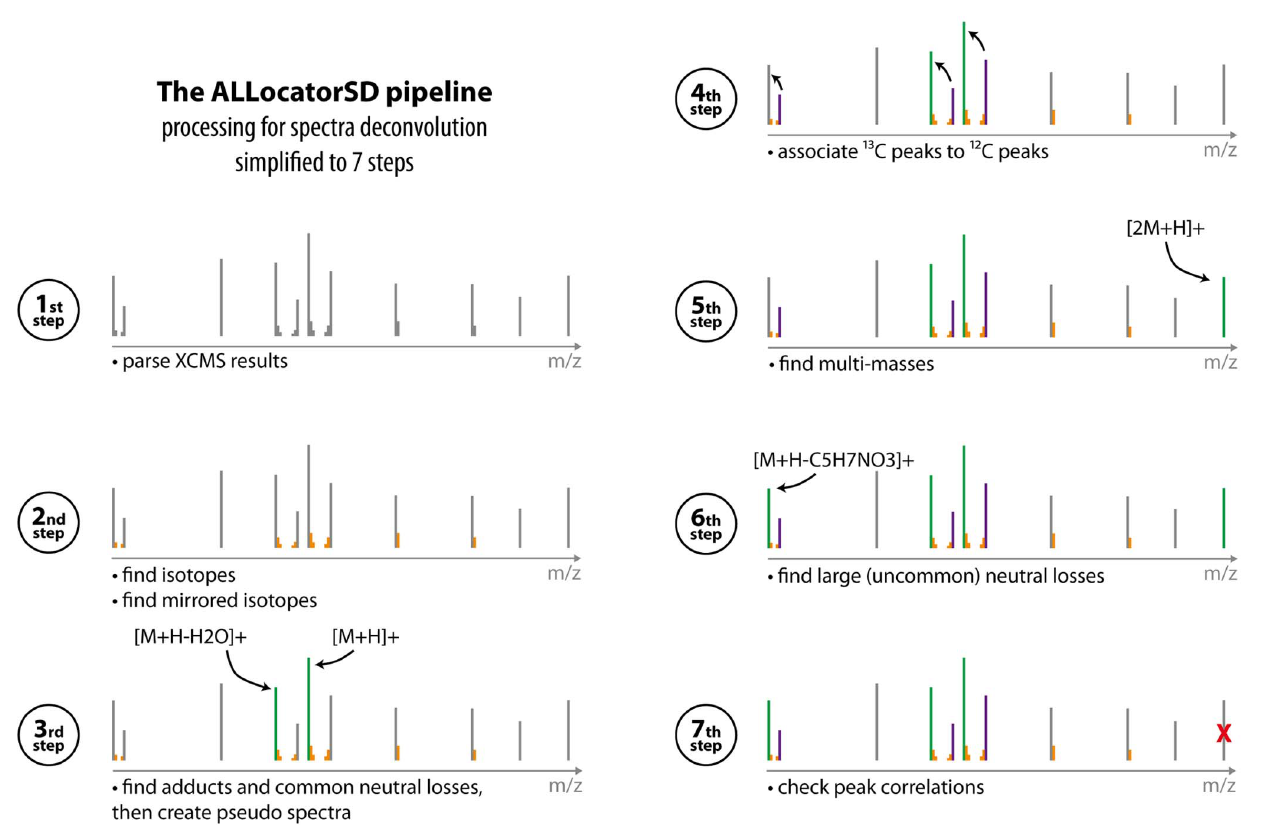
Figure 2. Summary of the ALLocatorSD pipeline for pseudo spectra allocation and peak annotation, divided into seven steps: Reading peaks from the XCMS output (1 st step), identification of isotopes (2 nd step), computation of pseudo spectra based on common adducts and neutral losses (3 rd step), association of 13 C monoisotopic peaks to 12 C monoisotopic peaks (4 th step), identification of homoadducts (5 th step), identification of large (uncommon) neutral losses (6 th step), and a check for peak correlations to validate pseudo spectra (7 th step).